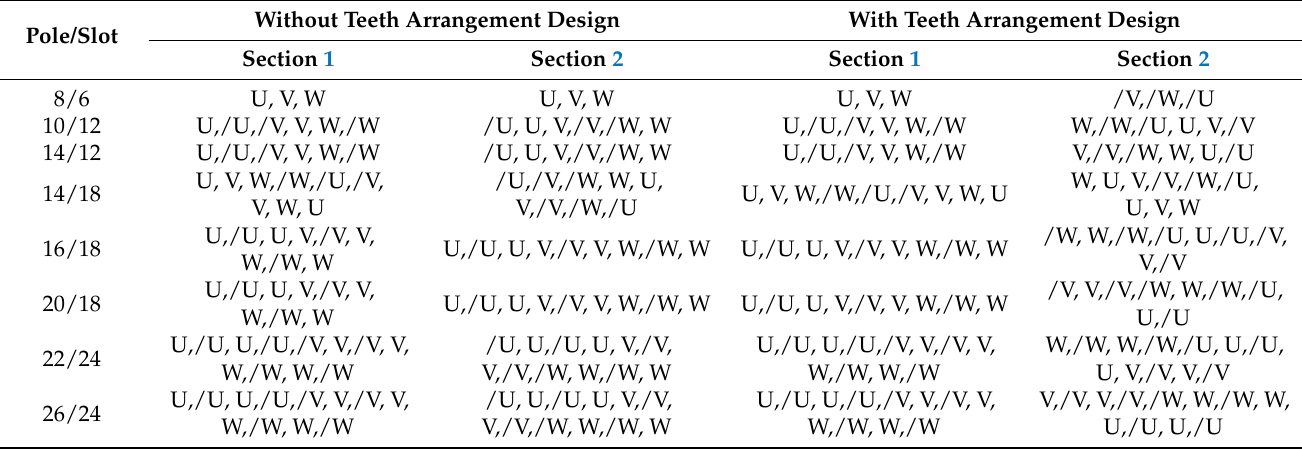
Table 2. Phase distribution changes by teeth arrangement design.